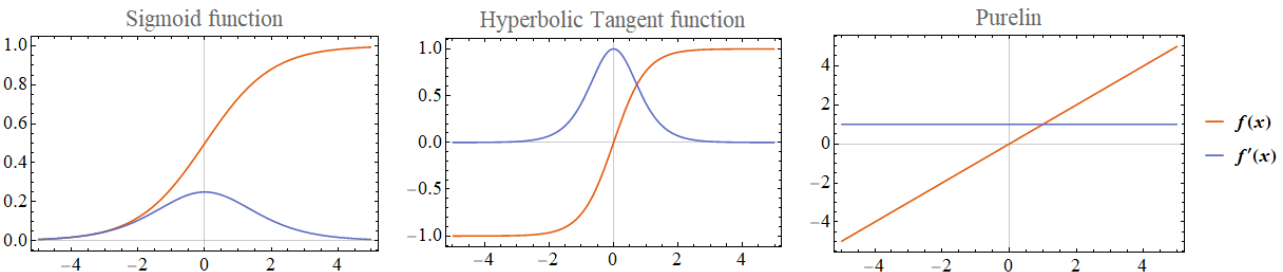
Figure 2. Transfer functions. Left : Sigmoid transfer function; middle : Hyperbolic-tangent transfer function; and right : Purelin transfer